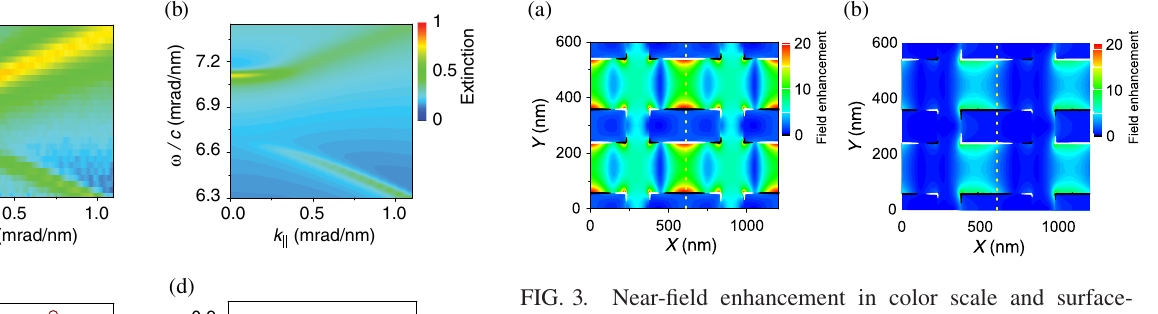
FIG. 3. Near-field enhancement in color scale and surface- charge distribution (at an arbitrary phase) in black and white at the midheight of the nanorods for the (a) ðþ 1 ; 0 Þ and (b) ð(cid:3) 1 ; 0 Þ surface lattice resonance at k k ¼ 0 : 15 mrad = nm . The dotted lines indicate the plane of symmetry for coupling to